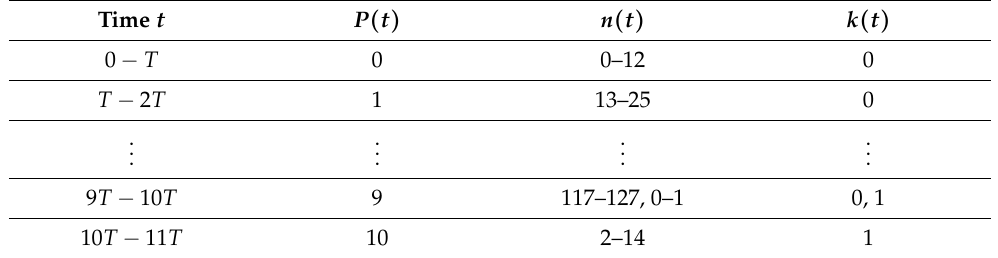
Table 1. Generator function bit index integer ranges for several PRI ( T ) time